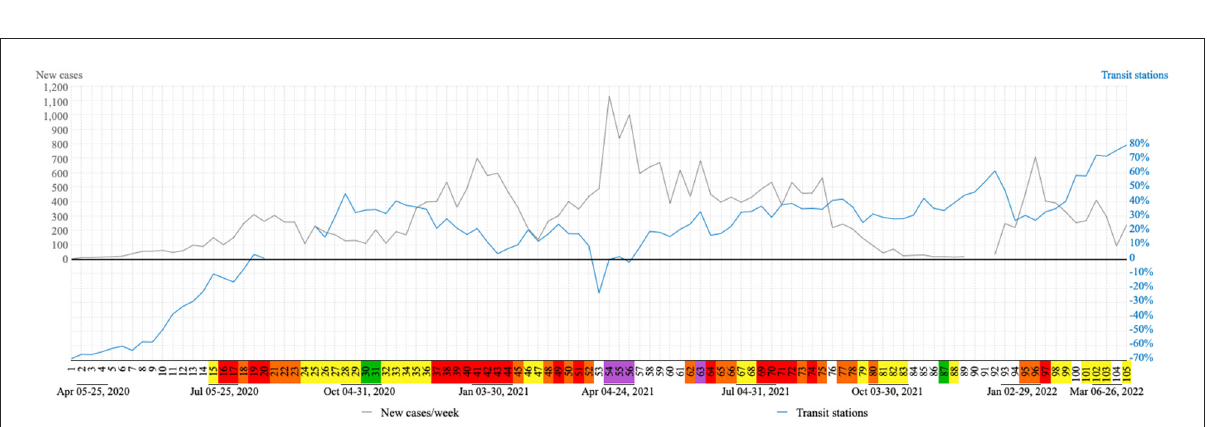
FIGURE9 Relationship between transit station and COVID-19 cases. Flag colors: green, very low; yellow, low; orange, moderate; red, high; purple, very high risk.